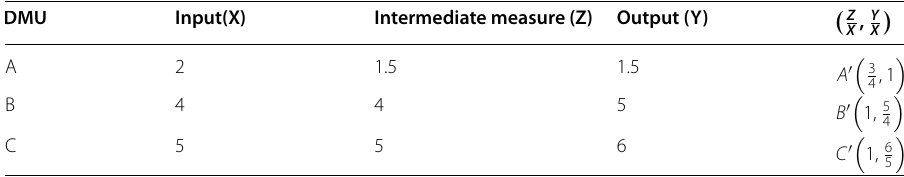
Table 1 Example 1. Data set for DMUs (Extracted from Izadikhah and Farzipoor 2016)